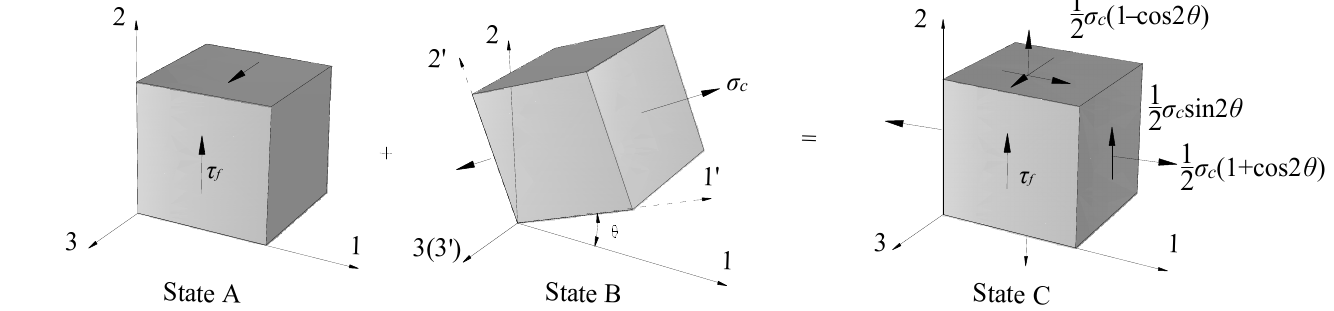
Figure 3. Analytical results of the interface stresses: ( a ) circumferential stress; ( b ) radial stress. For the concrete beams or columns reinforced with CFRP, the reinforced interface is mostly flat and mainly in a pure shear state (State A), as shown in Figure 4. For the circular tunnel reinforced with CFRP on the internal surface, the reinforced interface is a curved surface. The analytical results show that the existence of interface curvature causes not only circumferential stresses (State A) but also radial stresses (State B) to exist on the curved reinforced interface. Therefore, the interface stress state (State C) of the curved reinforced interface is more complex than that of the plane interface.